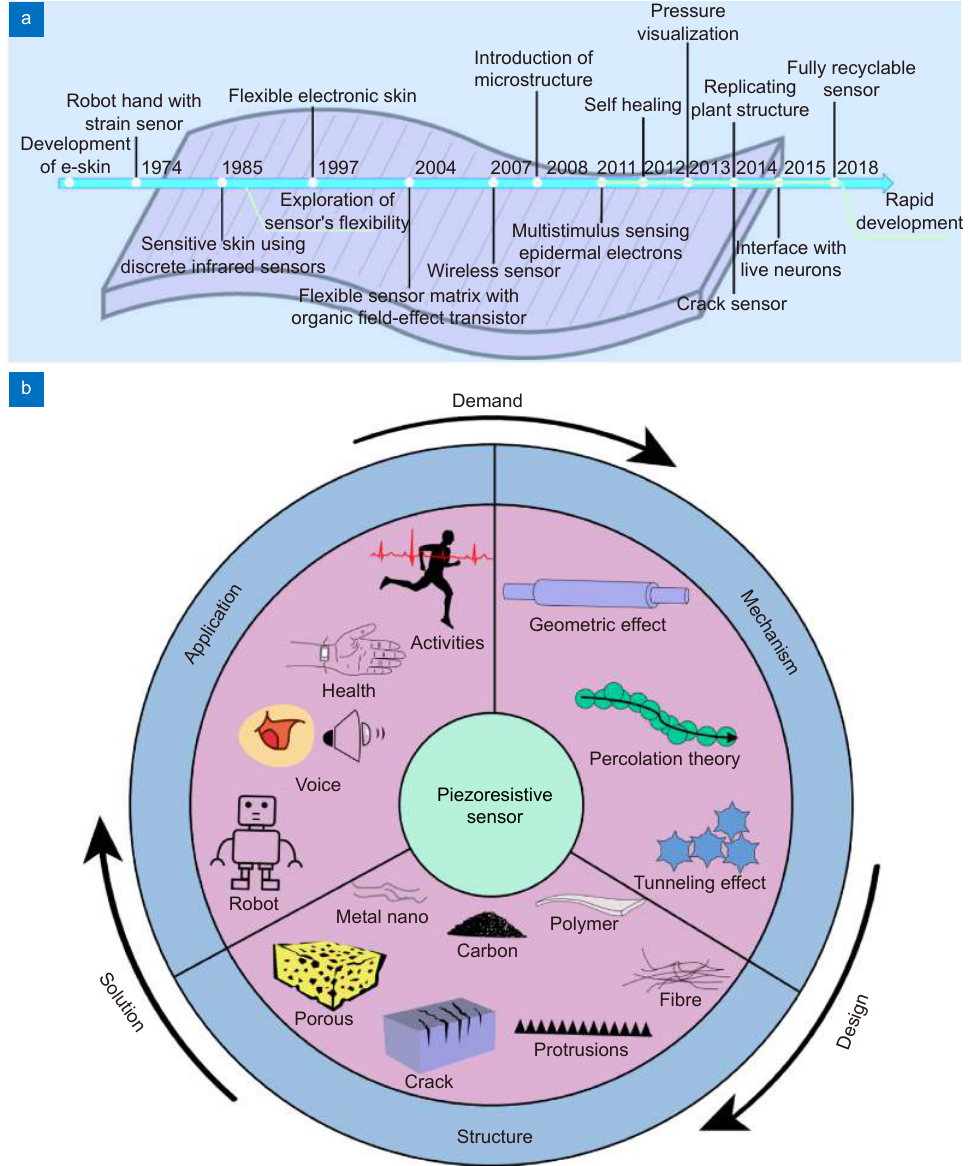
Fig. 1 | Piezoresistive designs for engineering electronic skin. ( a ) Developmental history of flexible skin-like electronics (e.g. milestones in the shear force measurement, large-area manufacturing, spatial mapping, bioinspired manufacturing, interconnection between e-skin and live neurons, and self-healing capability) 10−17 . ( b ) Scheme illustrating the design and applications of piezoresistive